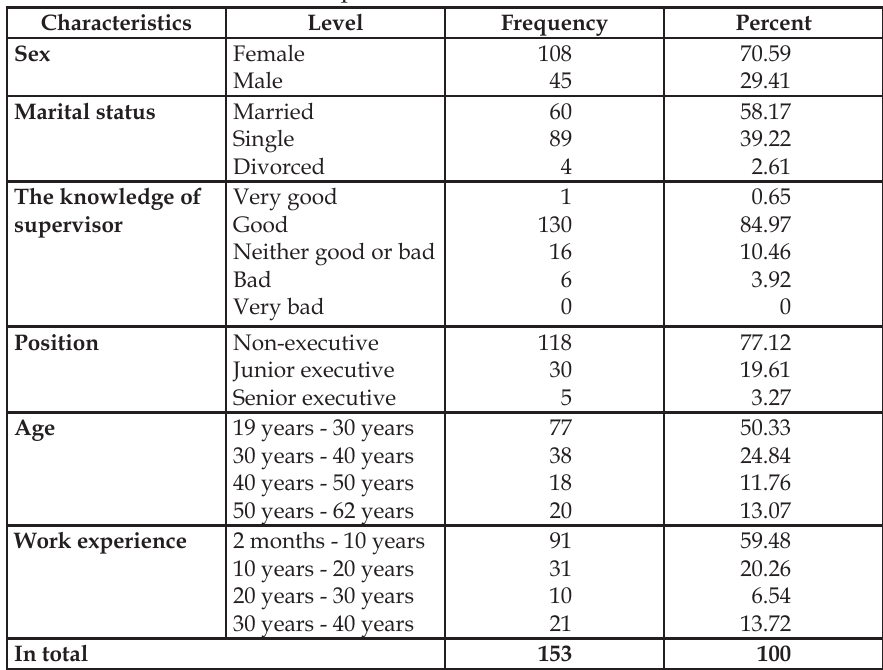
Table 1. A structure of the